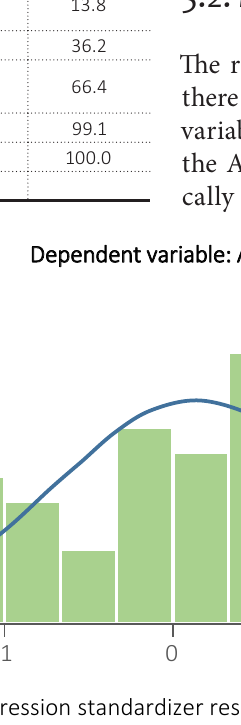
Figure 1. Regression standardized